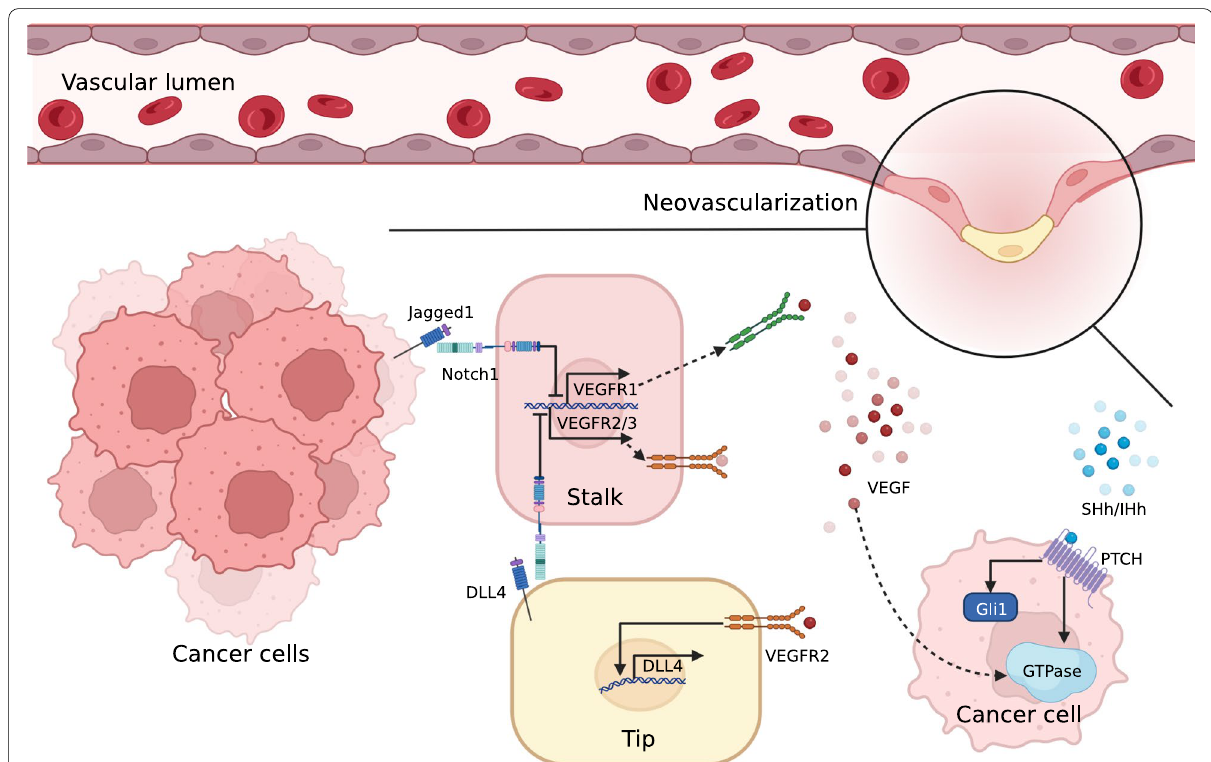
Fig. 4 Notch- and Hh-mediated tumor